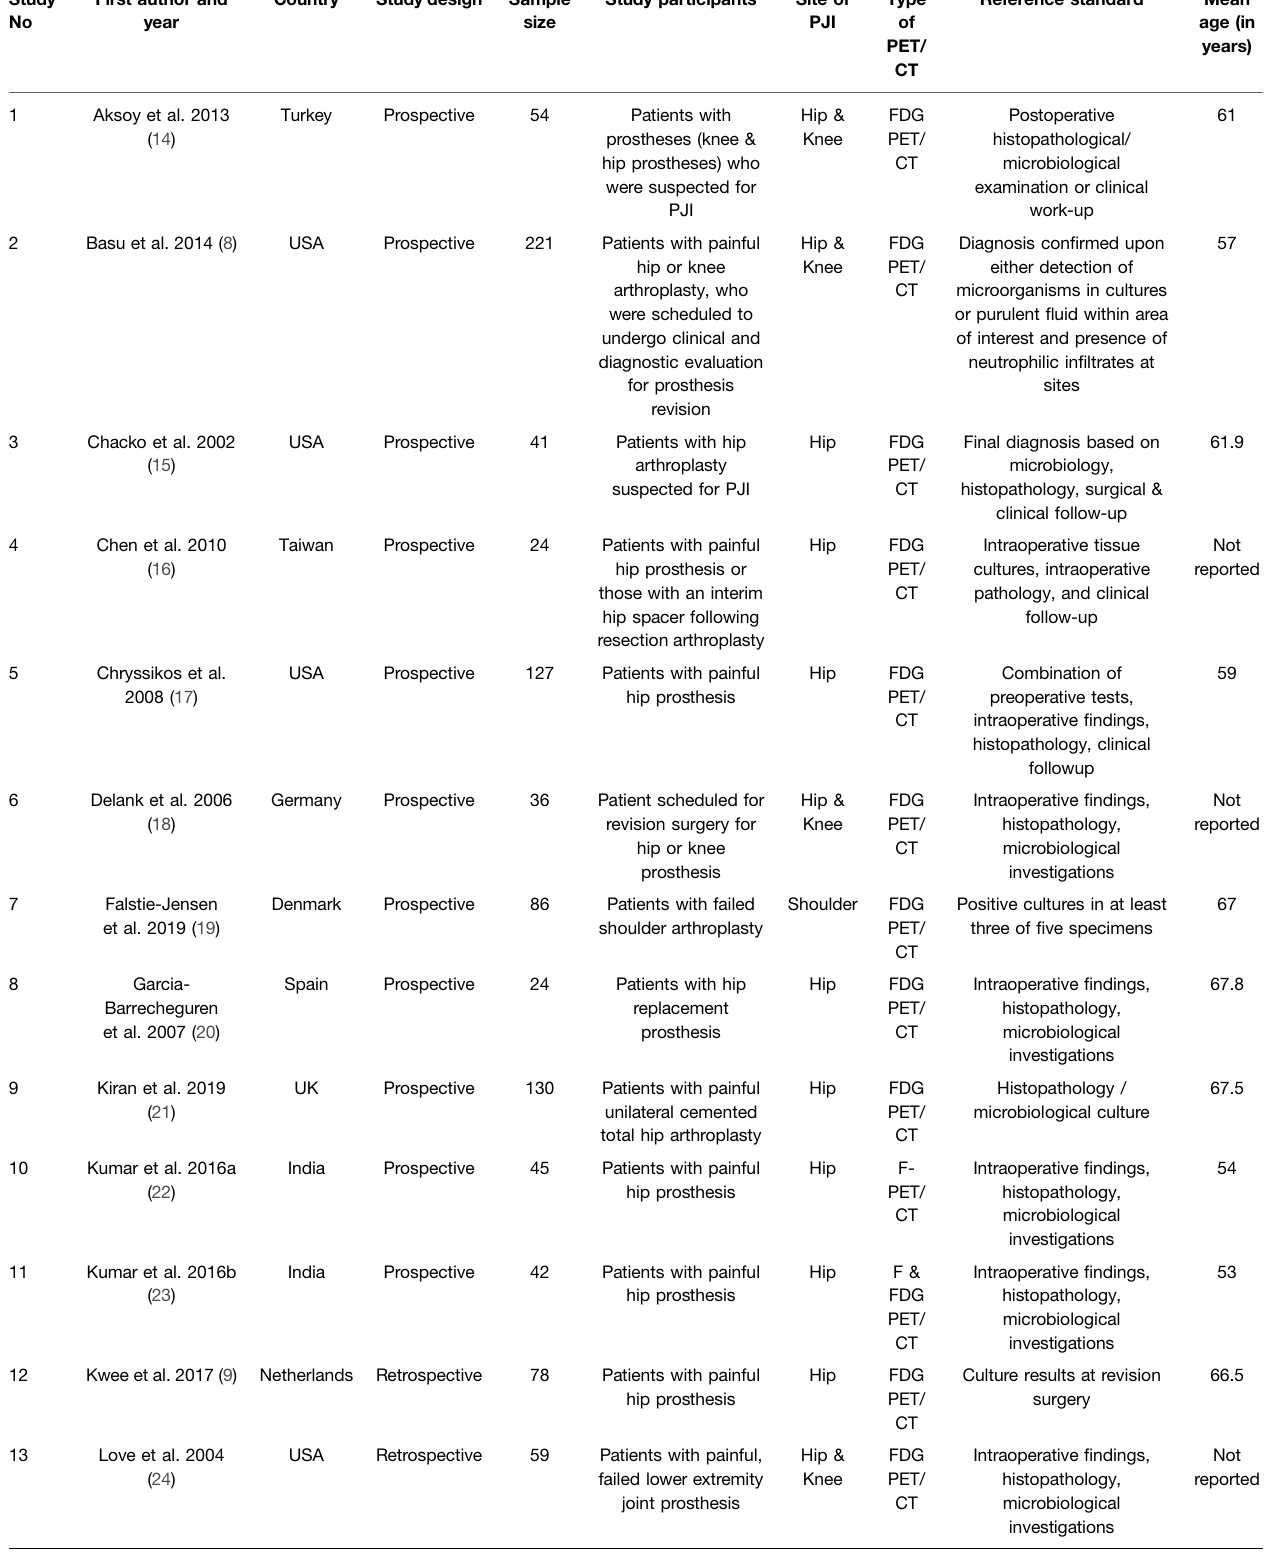
TABLE 1 | Characteristics of the included studies ( N